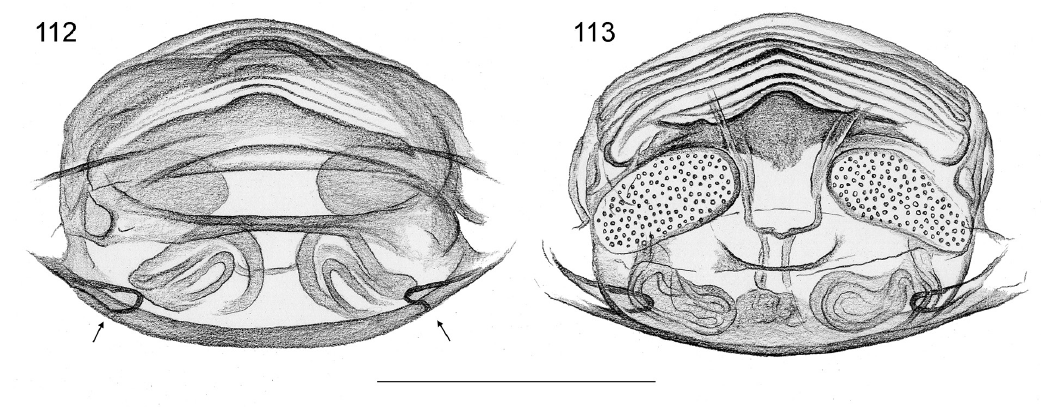
Figs 112-113. Quamtana kitahurira Huber, 2003. Cleared ♀ genitalia, ventral and dorsal views. Arrows point at epigynal pockets. Scale line: 0.2